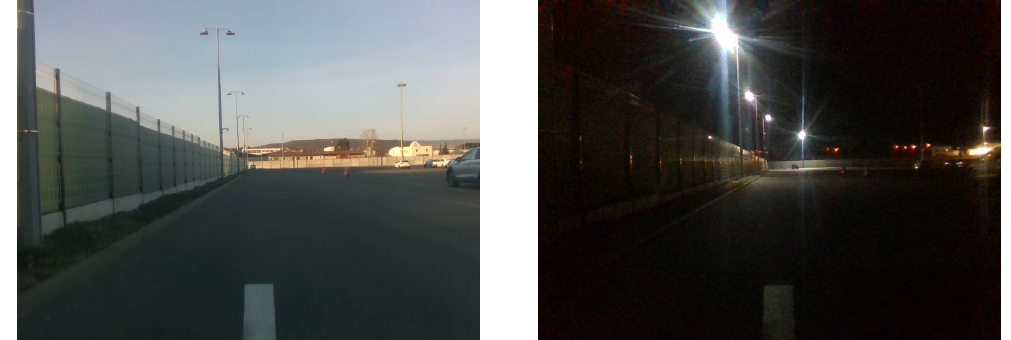
Figure 11. Example of an alignment task of two images with significant time and conditions difference captured at the location of the experiment. The daytime image was used for teaching; the nightime image was part of the repeat phase deployment.